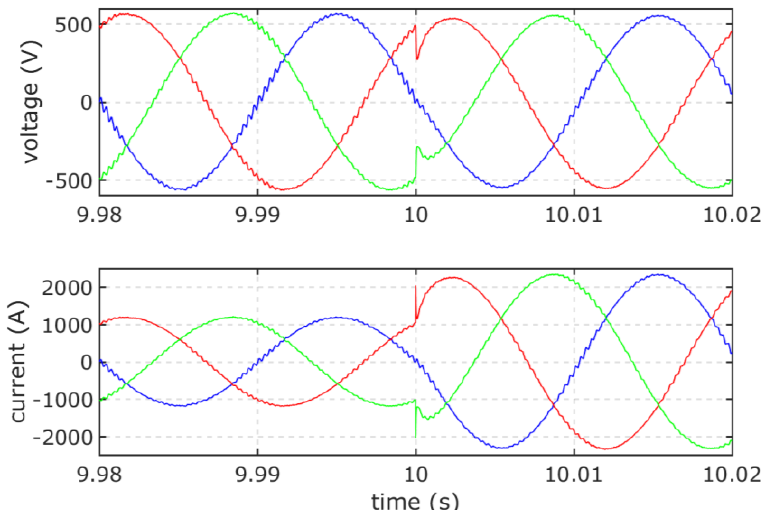
Figure 10. Operation at variable load and constant wind speed: instantaneous load voltage and current under active power step (phase a-red; phase b-green; phase c-blue).